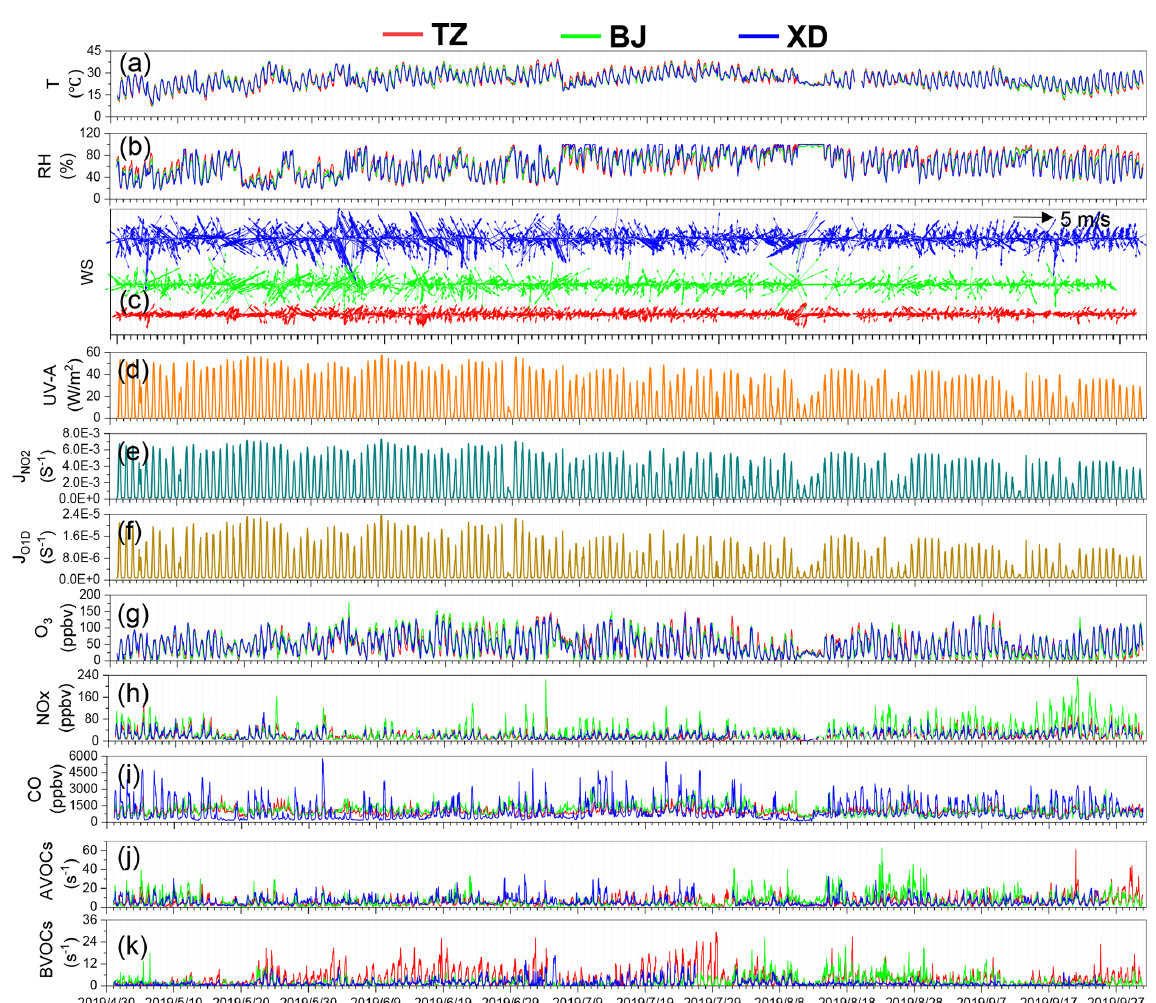
Figure 2. Time series of meteorological parameters, O 3 , and its precursors (i.e., CO, NO x , VOCs) throughout the whole campaign at the three sites in